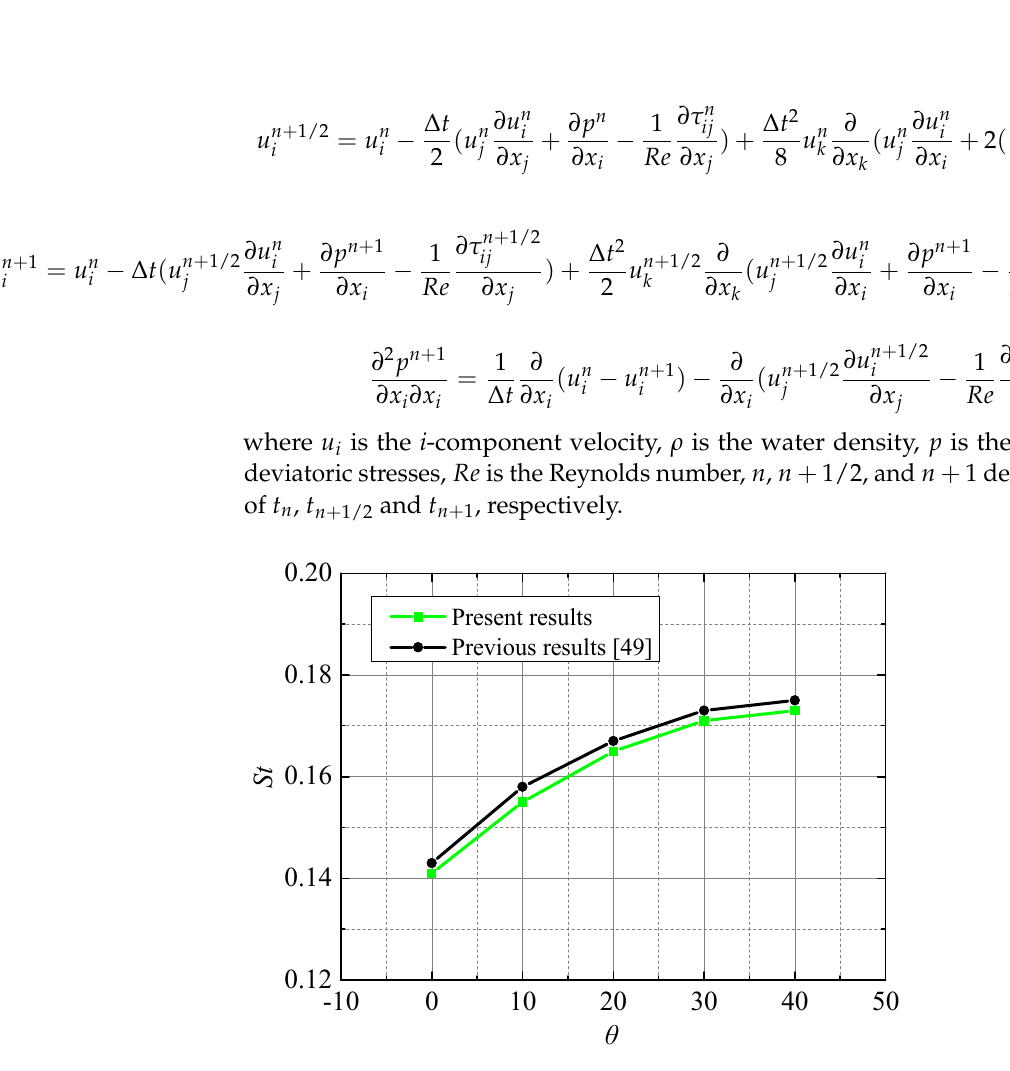
Figure 2. Simulated results comparing with previous results.